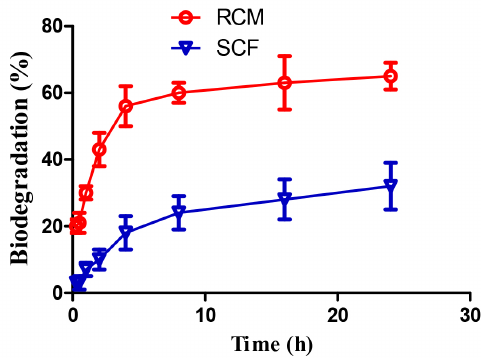
FIGURE 5 ‑ Biodegradation of the optimal film in SCF and RCM.